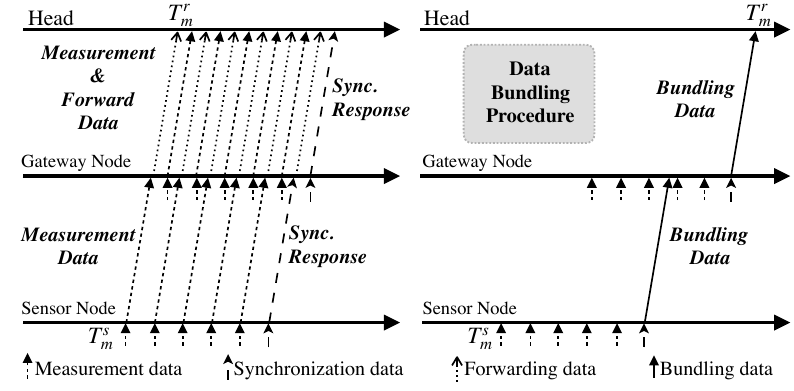
Figure 2. Payload contents of the data bundling procedure introduced in EE-ASCFR [1].